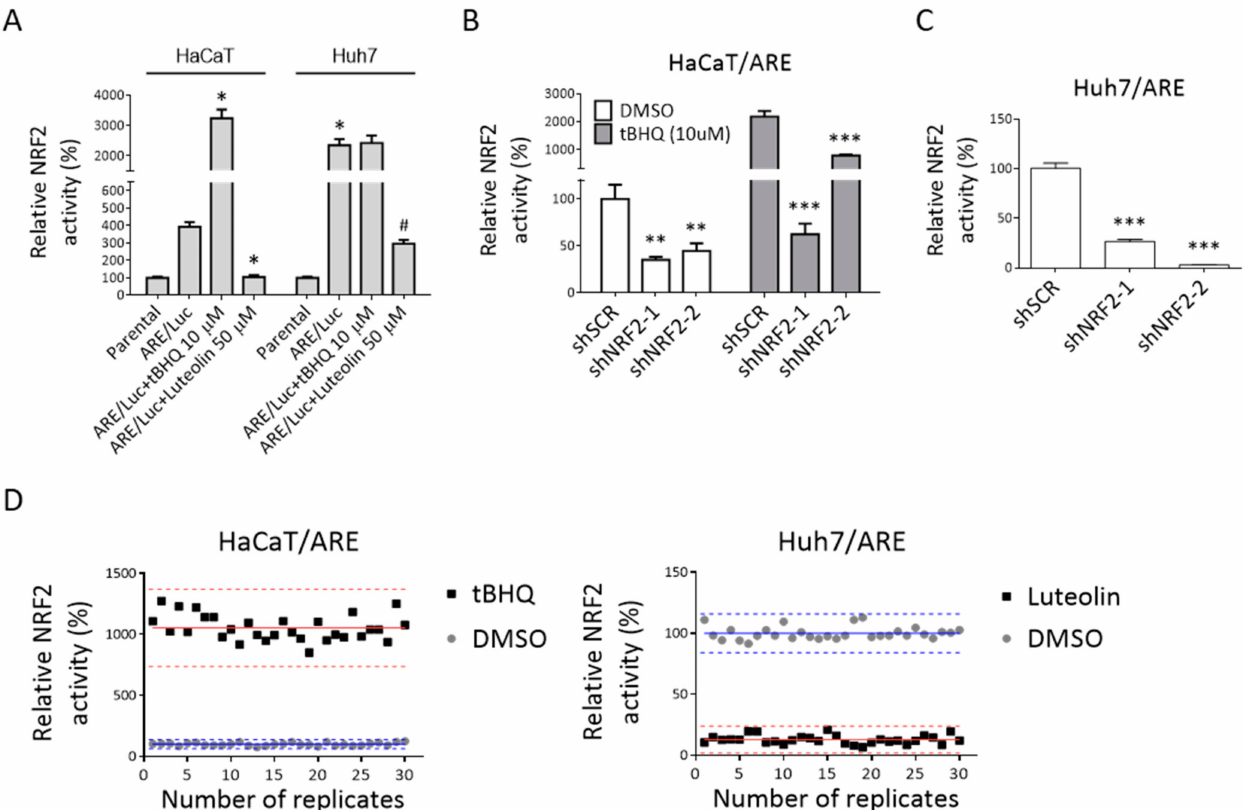
Figure 1. Establishment of high-throughput screening (HTS) platforms for selective NRF2 regulator screening. ( A ) NRF2 reporter fragment (ARE/Luc) was stably expressed in HaCaT cells (HaCaT/ARE) and Huh7 cells (Huh7/ARE). Luciferase activity and cell viability were measured in these two stable cell lines and their corresponding parental cells. Relative luciferase activity (RLA) was calculated as described in Section 2. Luteolin and tert-butylhydroquinone were used as NRF2 inhibitor and activator, respectively. The average of RLA in parental cells was used as a standard for 100%. The graph shows the means ± SD ( n = 6). * indicates significant difference from HaCaT/ARE; # indicates significant difference from Huh7/ARE by one-way ANOVA. ( B , C ) Knock-down of NRF2 by shRNAs dramatically reduced NRF2 reporter activity in HaCaT/ARE cells ( B ) and Huh7/ARE cells ( C ). * indicates significant difference from control scramble shRNA (shSCR) group (** p < 0.01, *** p < 0.001, one-way ANOVA). ( D ) Variation test for platform evaluation. Huh7/ARE and HaCaT/ARE cells were determined in two experimental groups: DMSO (circles) and tBHQ (10 µ M) or luteolin (50 µ M) (squares). In each group, 30 wells were tested. The average of the DMSO group was used as a standard for 100%. Each dot represents NRF2 activity for one well. Solid lines represent the mean relative NRF2 activity, and dashed lines represent ± 3 standard deviations (SDs) for each